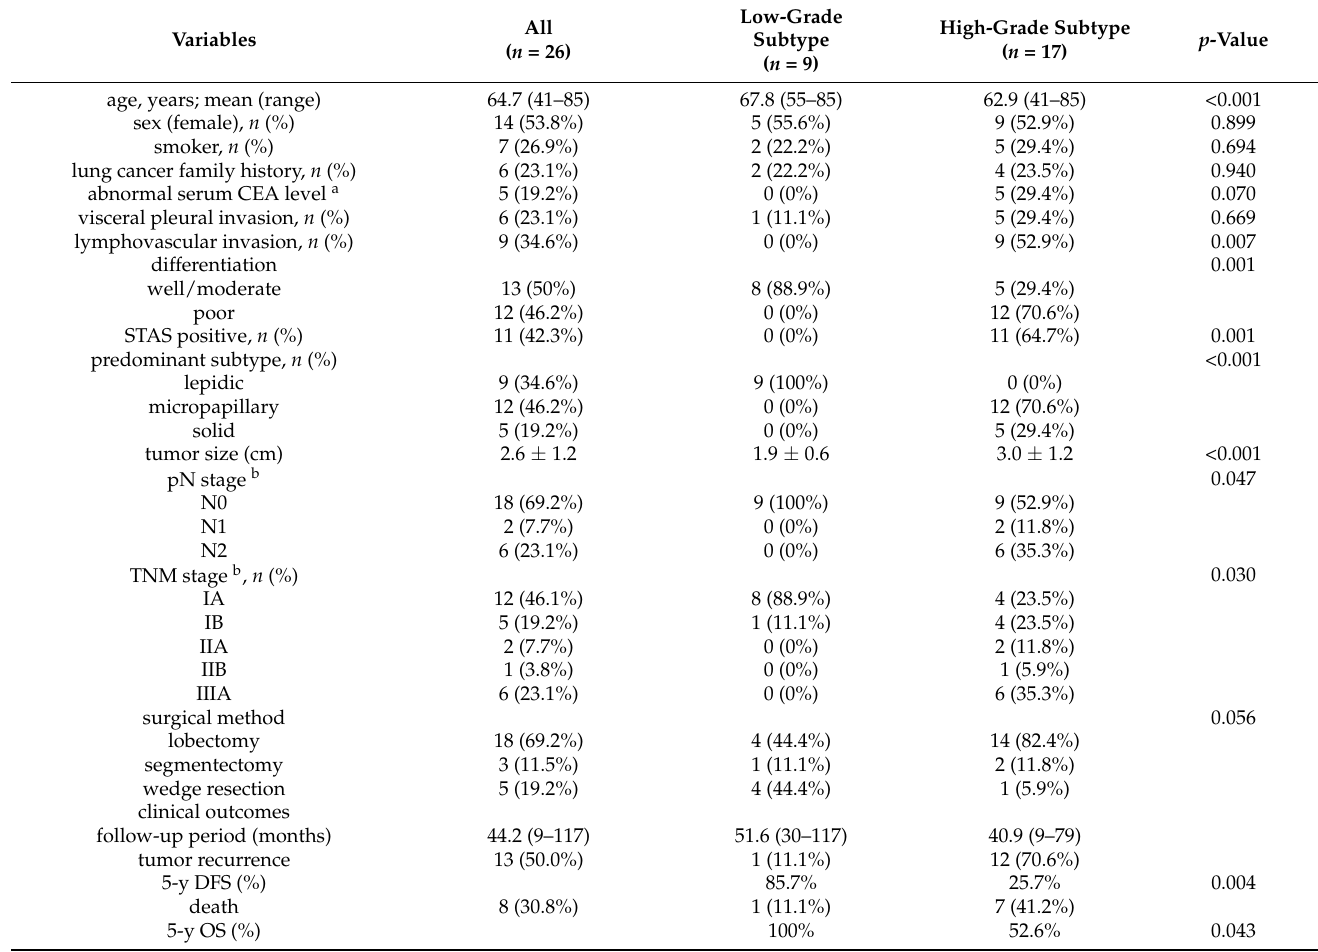
Table 1. Clinicopathological characteristics and clinical